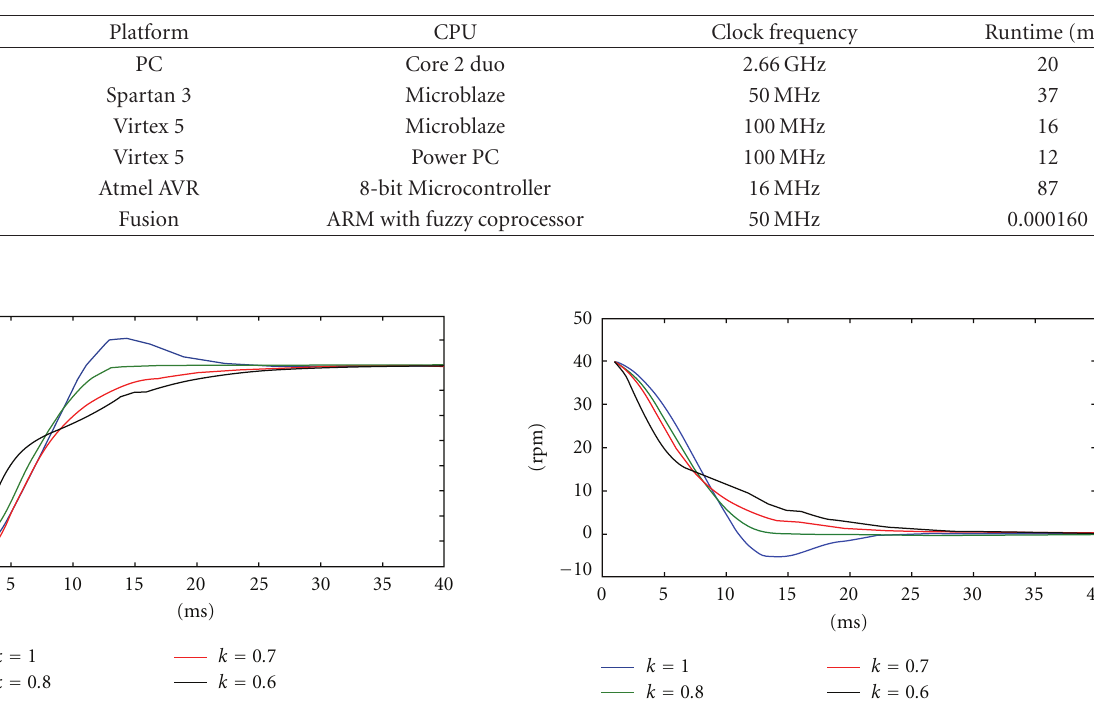
Figure 11: Actel development board for FPGA model “Embedded M1AFs1500 KIT.” Table 1: Comparing performance of FLC implementation for di ff erent development platforms.